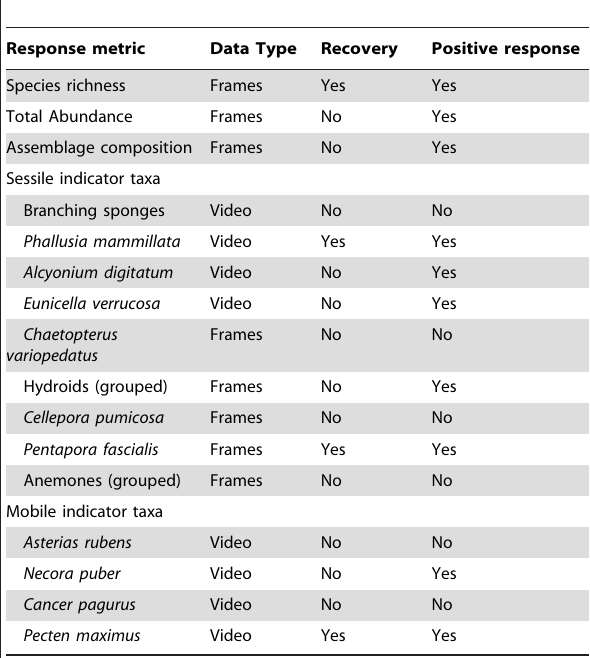
Table 4. Summary of recovery status with evidence from pairwise statistical tests (in supporting